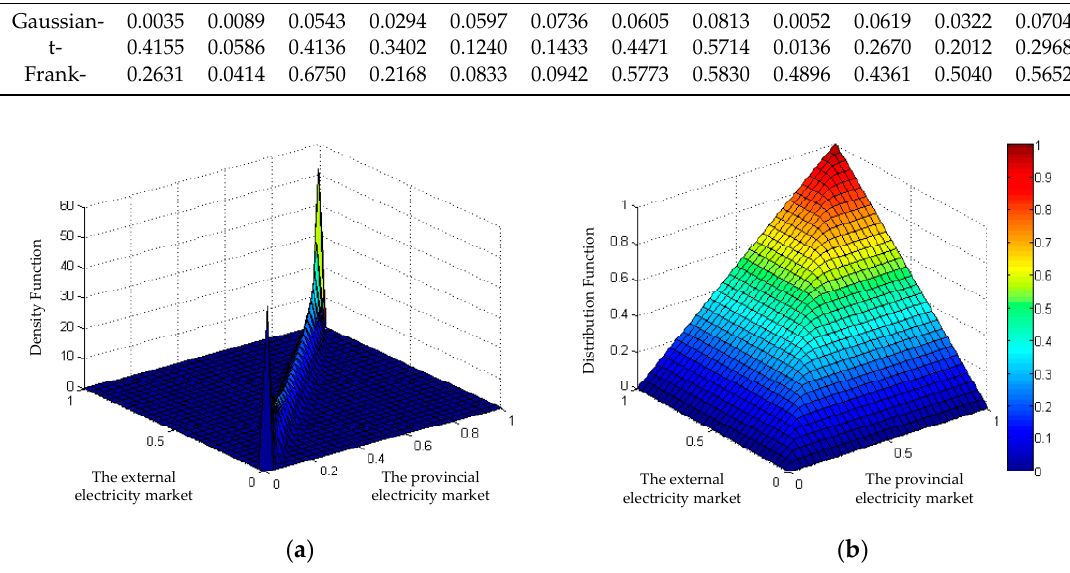
Figure 4. The density and distribution function of Gaussian-Copula in April ( p = 0.9949). ( a ) Density Function; ( b ) Distribution Function.